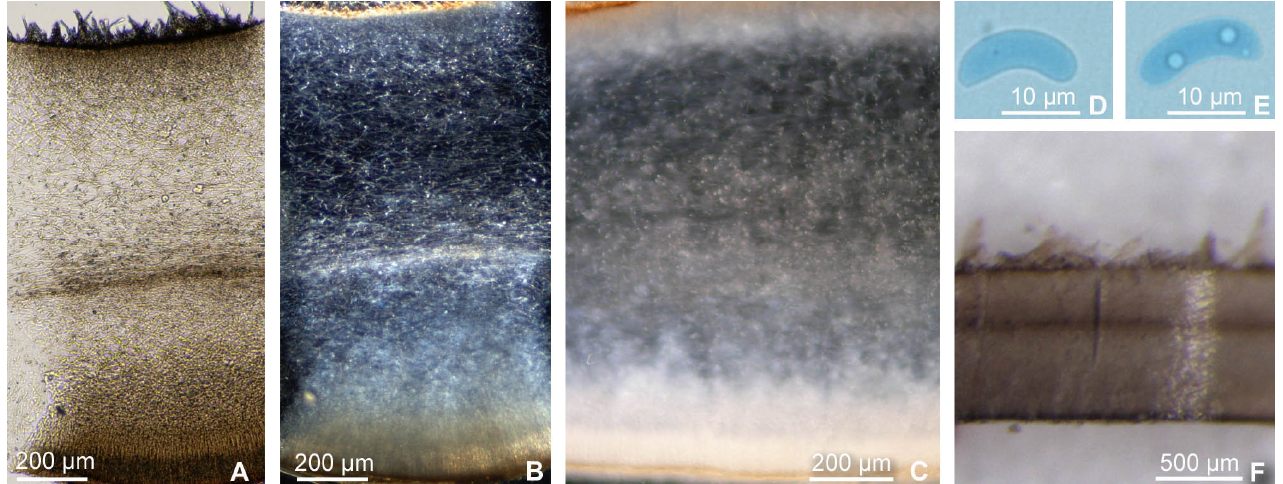
Figure 4. Microscopic features of Auricularia species: ( A , B ) Vertical section of basidiocarp A. cerrina (holotype) with visible medulla; ( C ) Vertical section of basidiocarp A. auricula-judae (JK 0512); ( D , E ) Basidiospores of A. cerrina (paratype HK 1510); ( F ) Medulla of A. cerrina (holotype) visible under stereomicroscope (dried specimen). Holotype: Czech Republic. B ř eclav District, near Valtice, Rendezvous National Nature Monument (48°44 ′ 53.780 ″ N, 16°47 ′ 31.863 ″ E), 200 m a.s.l., on lying branches of Quer- Isotype UPL, K.